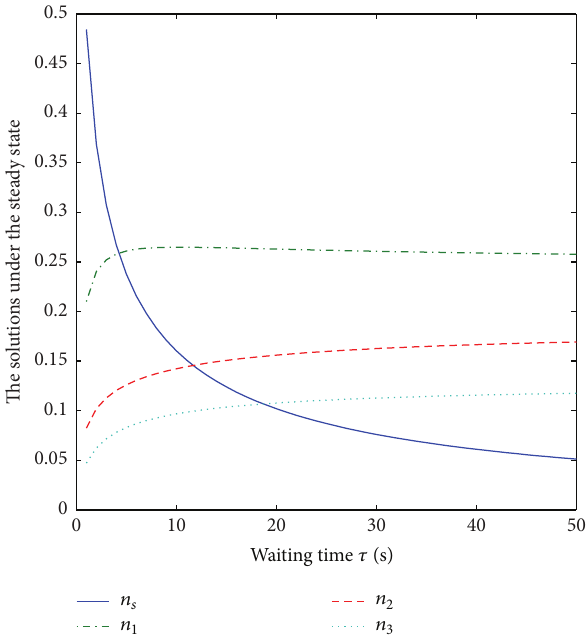
Figure 5: Solutions under the steady state for 𝛽 = 1.5 .